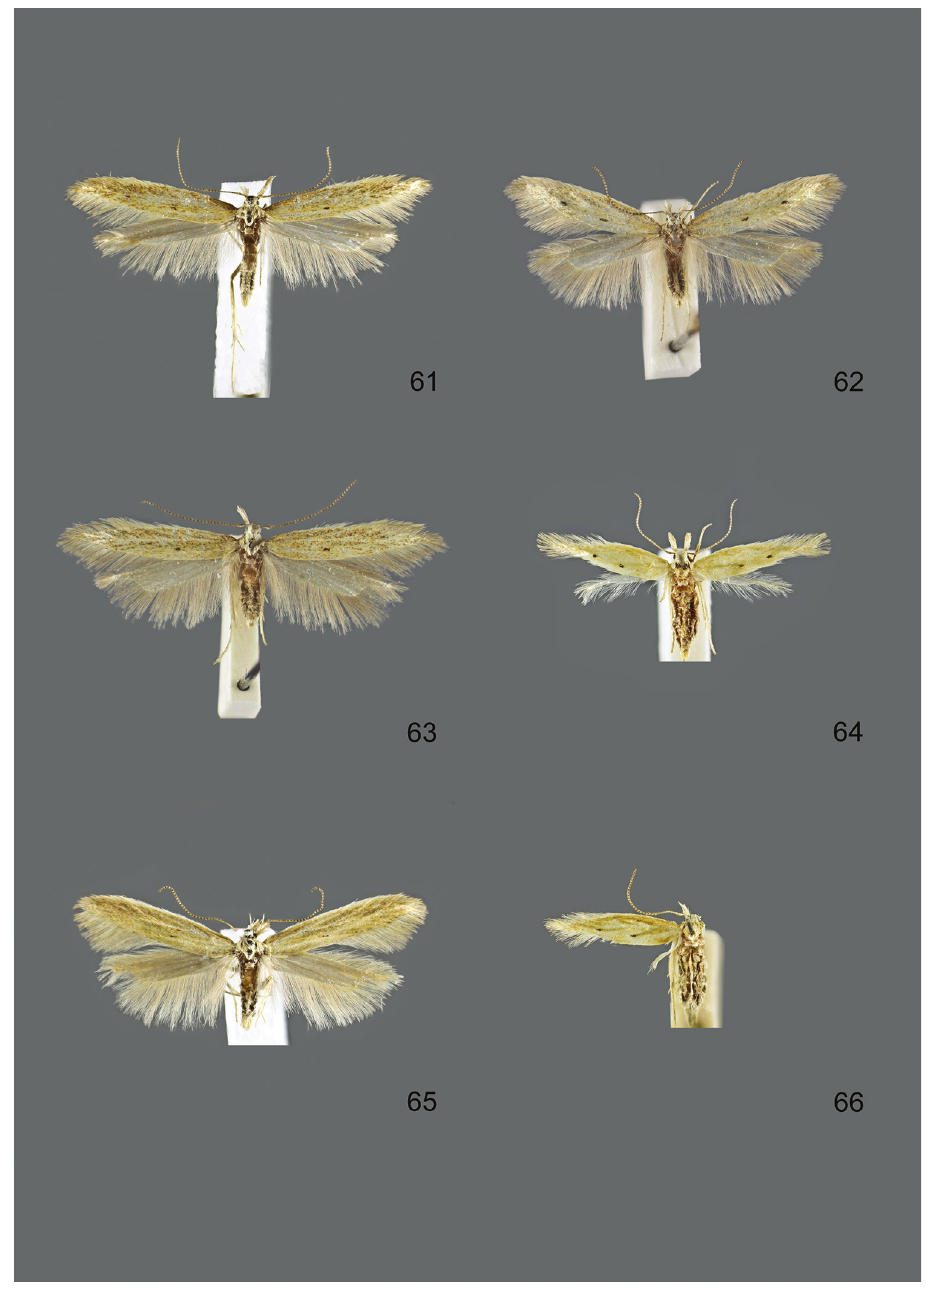
Figures 61–66. Megacraspedus adults in dorsal view. 61 M. devorator sp. n. – Paratype, male, Romania (RCJJ) 62 M. binotella (Duponchel, 1843) – male, Austria (RCEA) 63 M. binotella (Duponchel, 1843) – male, Austria (RCEA) 64 M. binotella (Duponchel, 1843) – female, Italy (TLMF) 65 M. brachypteris sp. n. – Paratype, male, Albania (NMPC) 66 M. brachypteris sp. n. – Paratype, female, Macedonia